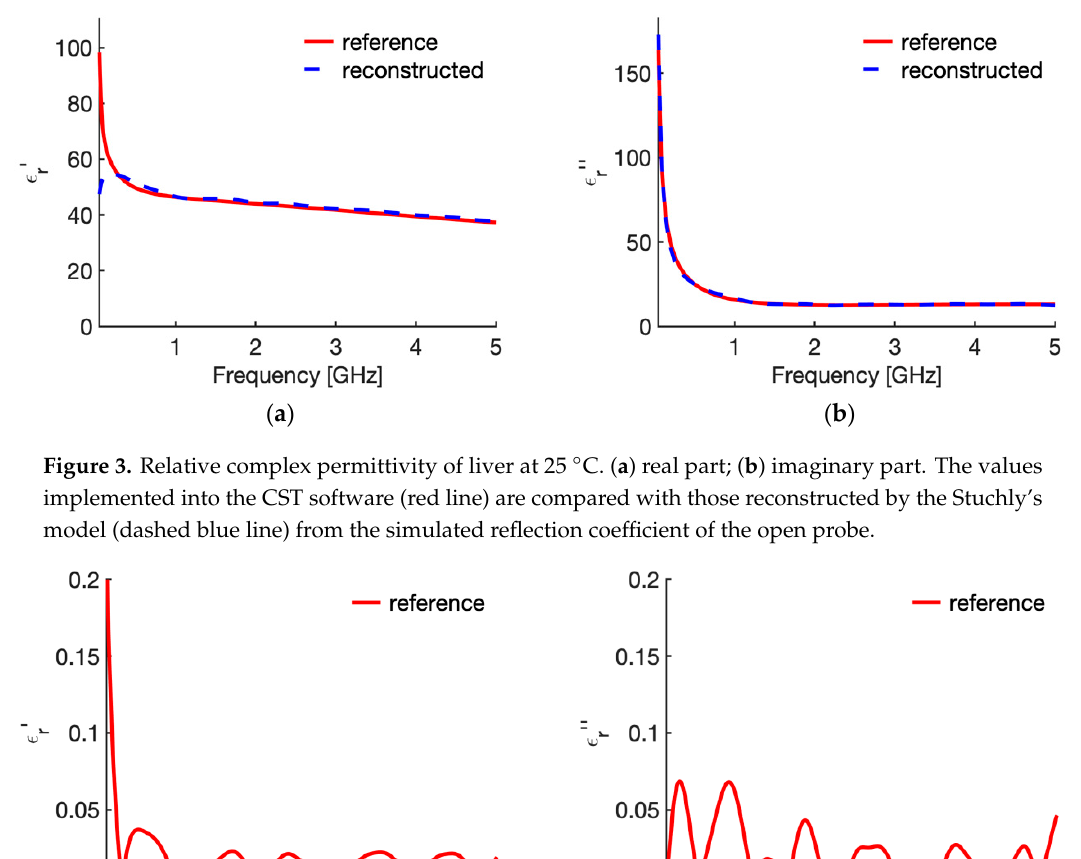
( a ) ( b ) Figure 5. Relative complex permittivity of fat at 25 °C. ( a ) real part; ( b ) imaginary part. The values implemented into the CST software (red line) are compared with those reconstructed by the Stuchly’s model (dashed blue line) from the simulated reflection coefficient of the open probe. ( a ) ( b ) Figure 6. Percentage errors in the evaluation of the relative complex permittivity of fat at 25 °C through the reflection arrangement of the open probe technique. ( a ) real part; ( b ) imaginary part. From the figures an optimum agreement between the actual values and those reconstructed can be derived in the frequency range of the probe, i.e., from 0.5 GHz up to 5 GHz. In particular, figures